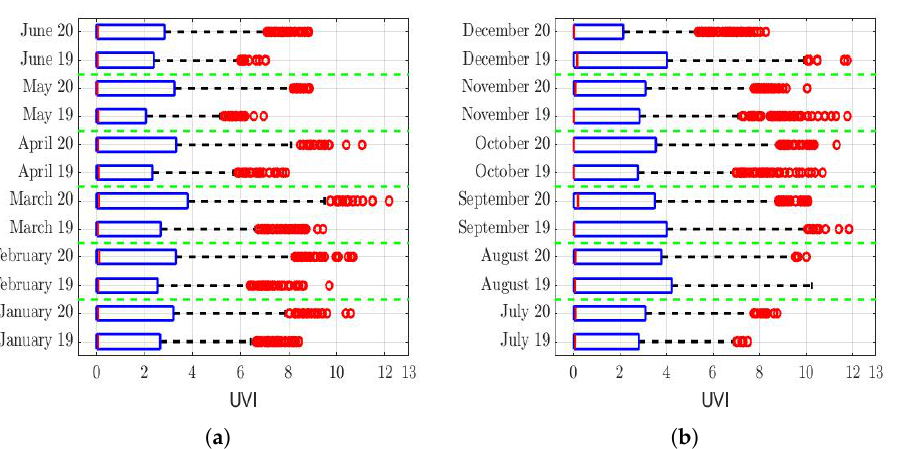
Figure 11. Box plot of the ultraviolet index (UVI): 2019 vs. 2020. The red circles represent the outliers. ( a ) First semester. ( b ) Second